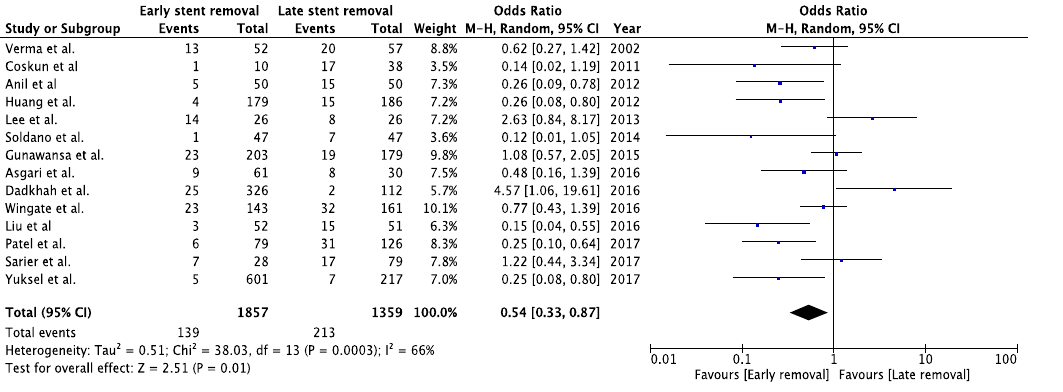
Figure 3. Forest plot of urinary tract infection for early ( < 3 weeks) versus late ( > 3 weeks) stent removal.